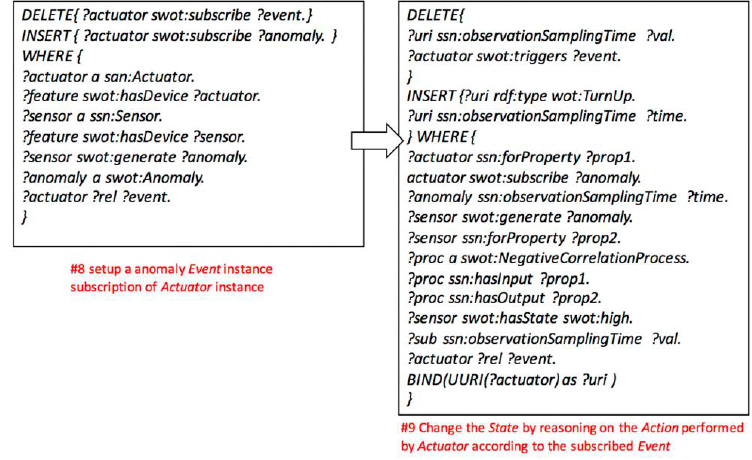
Figure 11. Creating the automatic control model.